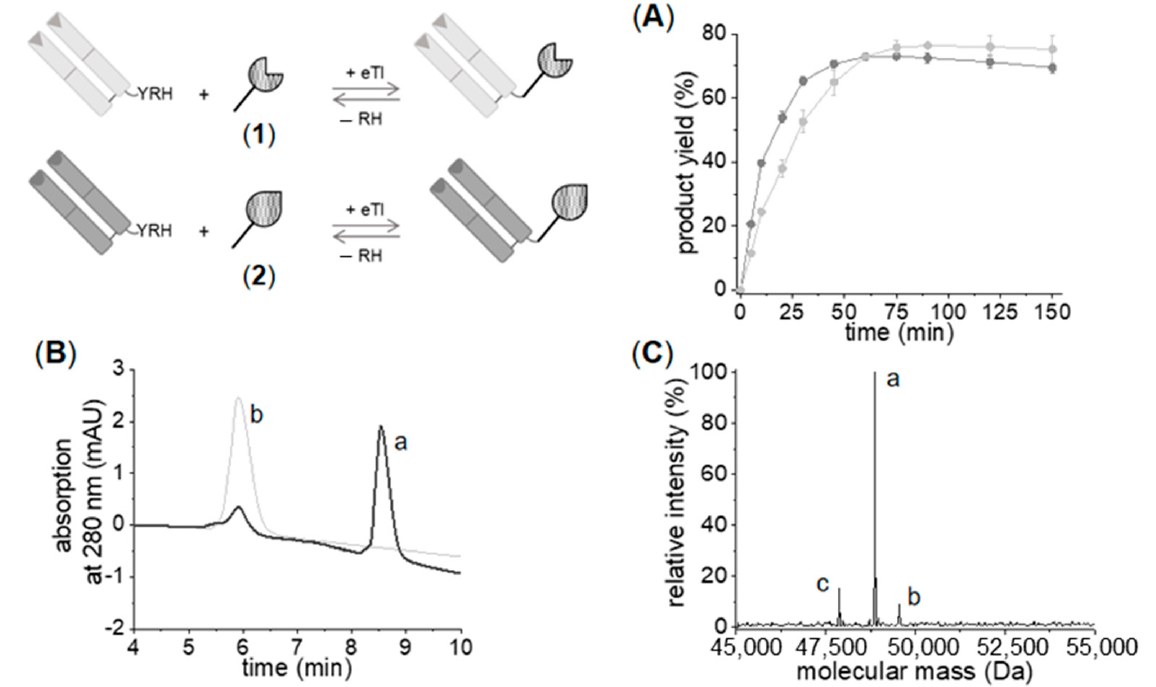
Figure 3. Coupling of anti-ErbB2-Fab-YRH and anti-ErbB3-Fab-YRH to click linkers 1 and 2 , respec- tively, via eTl-catalysis. ( A ) Reaction kinetics with maximum product yields higher than 72%, light grey line: anti-ErbB2-Fab-TCO, grey line: anti-ErbB3-Fab-MeTz; ( B ) HPLC analysis of the reaction mixture of anti-ErbB2-Fab-YRH with TCO click linker 1 at 0 min (light grey) and 75 min (dark grey) reaction times; ( C ) Mass spectrogram of the reaction mixture of anti-ErbB2-Fab-YRH with TCO click linker 1 after 75 min reaction time and after separation of excess click anchor via affinity chromatography (a: anti-ErbB2-Fab-TCO M calcd : 48,860 Da, M found : 48,861 Da, b: anti-ErbB2-Fab-YRH M calcd : 49,548 Da, M found : 49,549 Da, c: anti-ErbB2-Fab-Y-OH M calcd : 47,870 Da, M found : 47,871 Da). Light grey Fab: anti-ErbB3-Fab-YRH, dark grey Fab: anti-ErbB2-Fab-YRH; eTl: enhanced Trypsiligase. Reaction conditions: 100 µM anti-ErbB2-Fab-YRH and anti-ErbB3-Fab-YRH, 500 µM click linker 1 and 2 , 10 µM eTl, 100 µM ZnCl 2 , 100 mM HEPES/NaOH, pH 7.8, 100 mM NaCl, 10 mM CaCl 2.